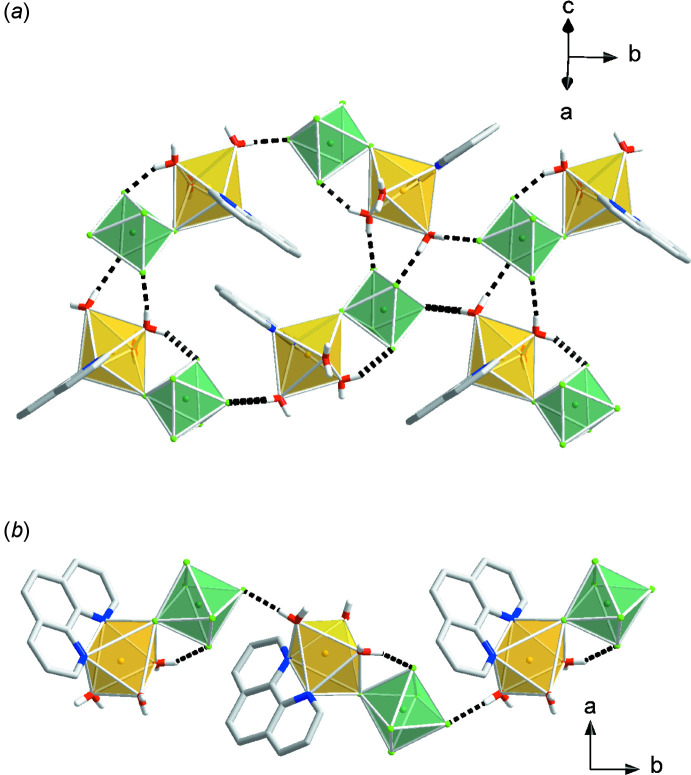
Packing diagrams of compound (II), [Cu(phen)(H2O)3(ZrF6)]·H2O, and compound (III), [Cu(phen)(H2O)3(HfF6)]·H2O. Yellow polyhedra represent Cu(phen)(H2O)3
2+ cations and green polyhedra represent ZrF6
2− or HfF6
2− anions.